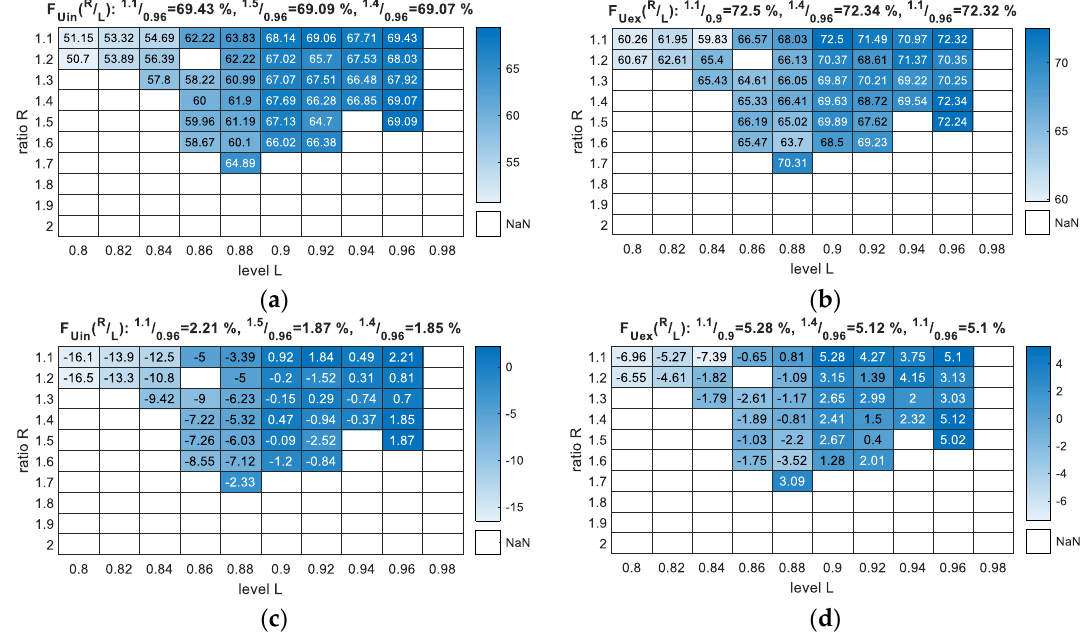
Figure 7. Classification F -measure output for the parameterisation of the NTF method with R and L variables (validation dataset): ( a ) F Uin —scores with U class included as an error; ( b ) F Uex —scores with U class excluded from measure; ( c ) F Uin —scores with U class included as an error in accordance with the best SVM result from Table 3; ( d ) F Uex —scores with U class excluded from measure in accordance with the best SVM result from Table 3.